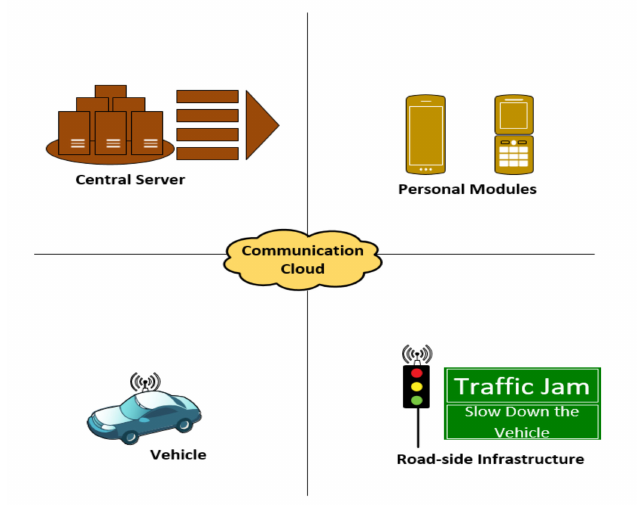
Figure 2. C-ITS architecture communication